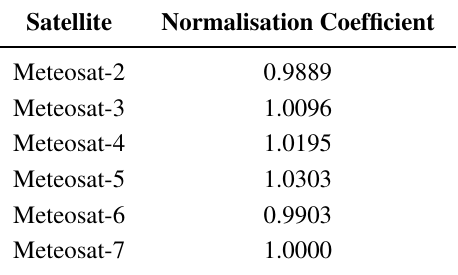
Table 6. The normalisation coefficients for each satellite with respect to the Meteosat-7 bright desert time series.